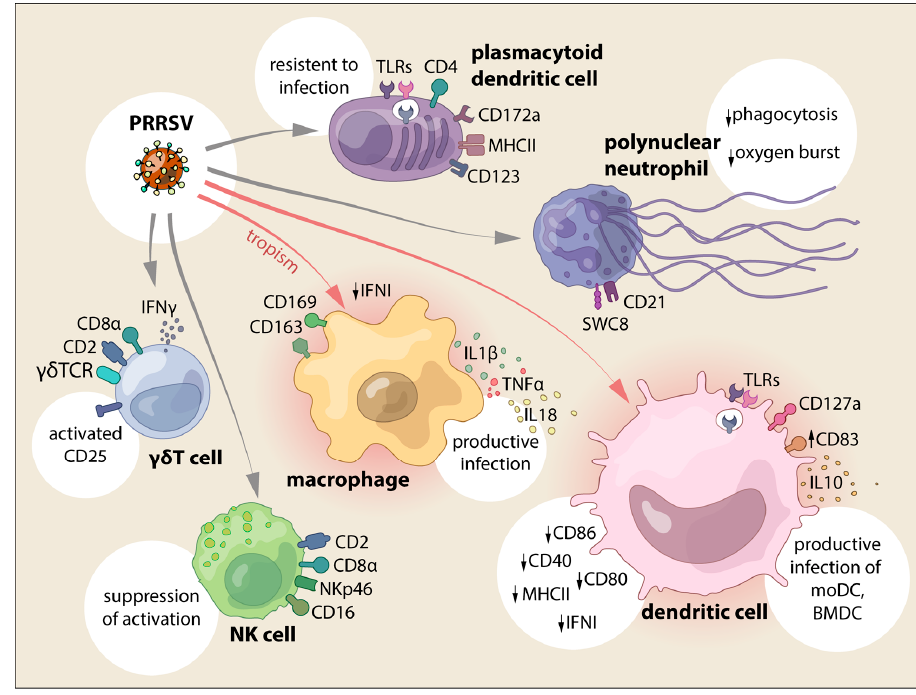
Figure 1. PRRSV interaction with cells from the innate immune system and the main effects reported. Vet. Sci. 2019 , 6 , x